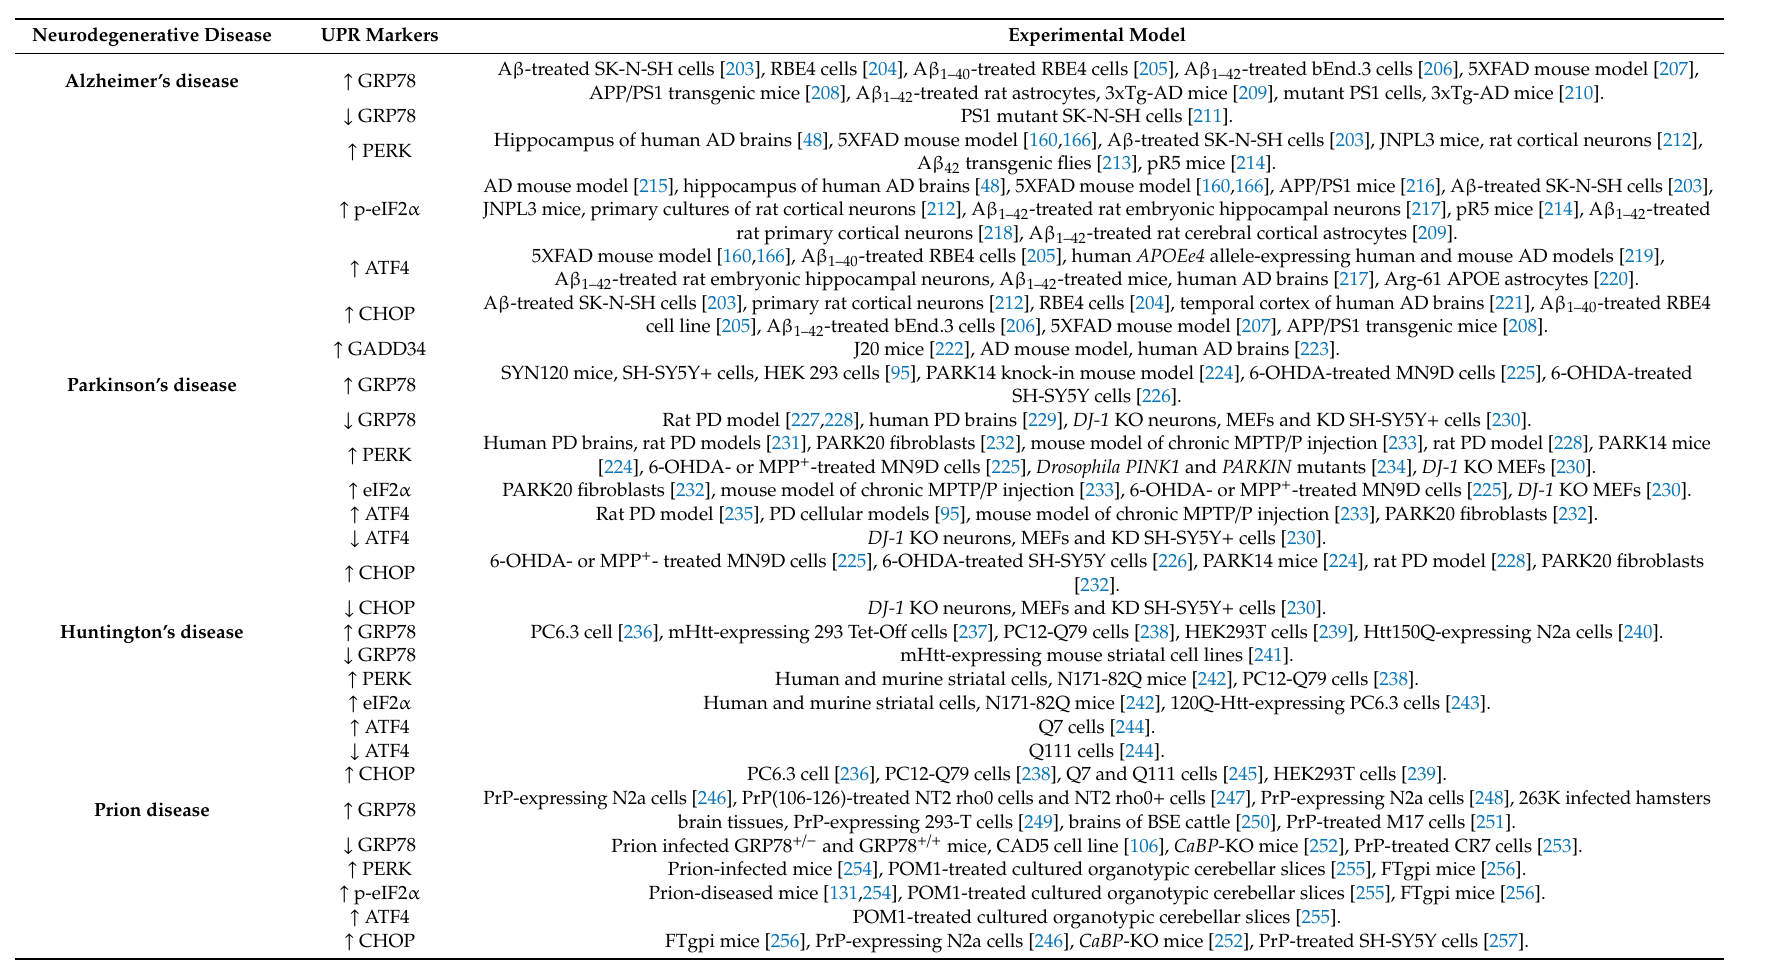
Table 1. The correlation between the expression of PERK-dependent unfolded protein response (UPR)-related proteins and proteostasis disturbances in various neurodegenerative disorders. The upregulation of specific UPR markers in the listed experimental models is indicated as an up-arrow ( ↑ ), whereas downregulation as a down-arrow ( ↓